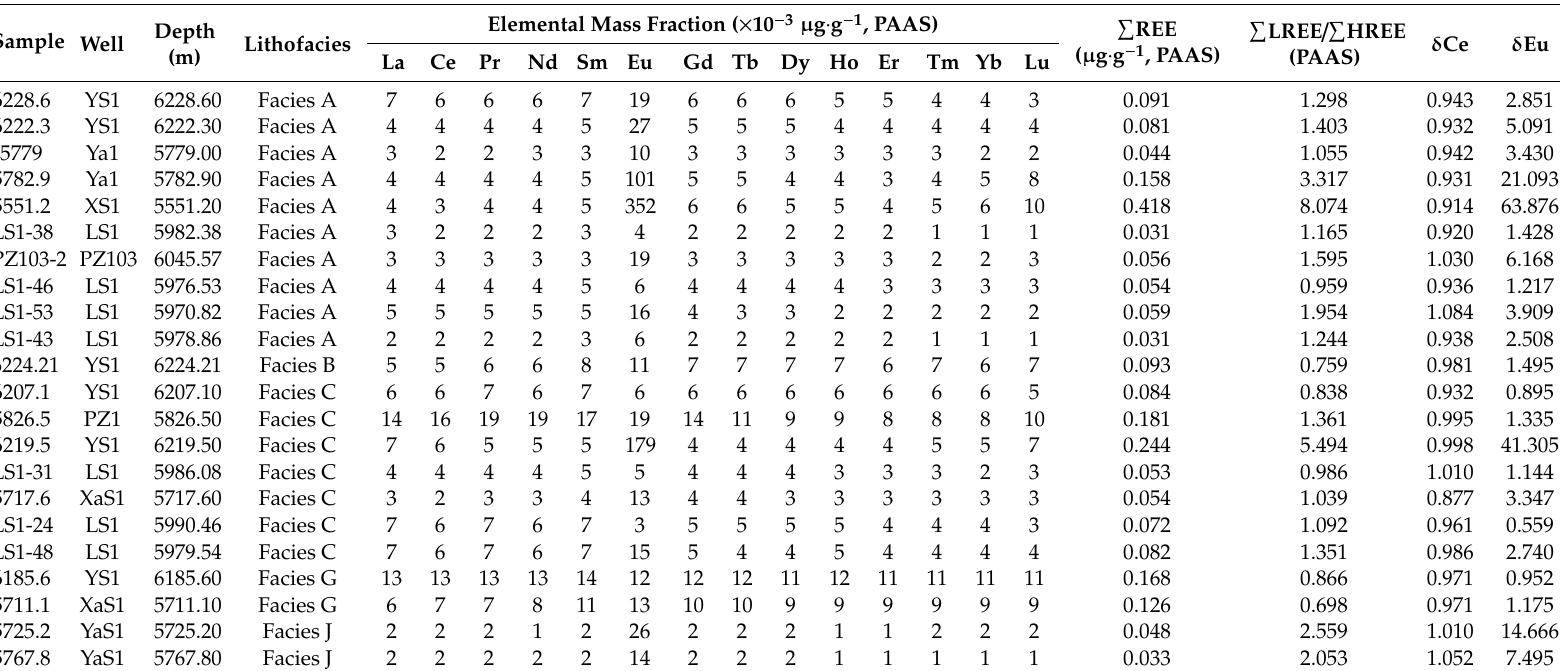
Table 4. Values of rare earth elements of di ff erent lithofacies in the fourth member of the Leikoupo